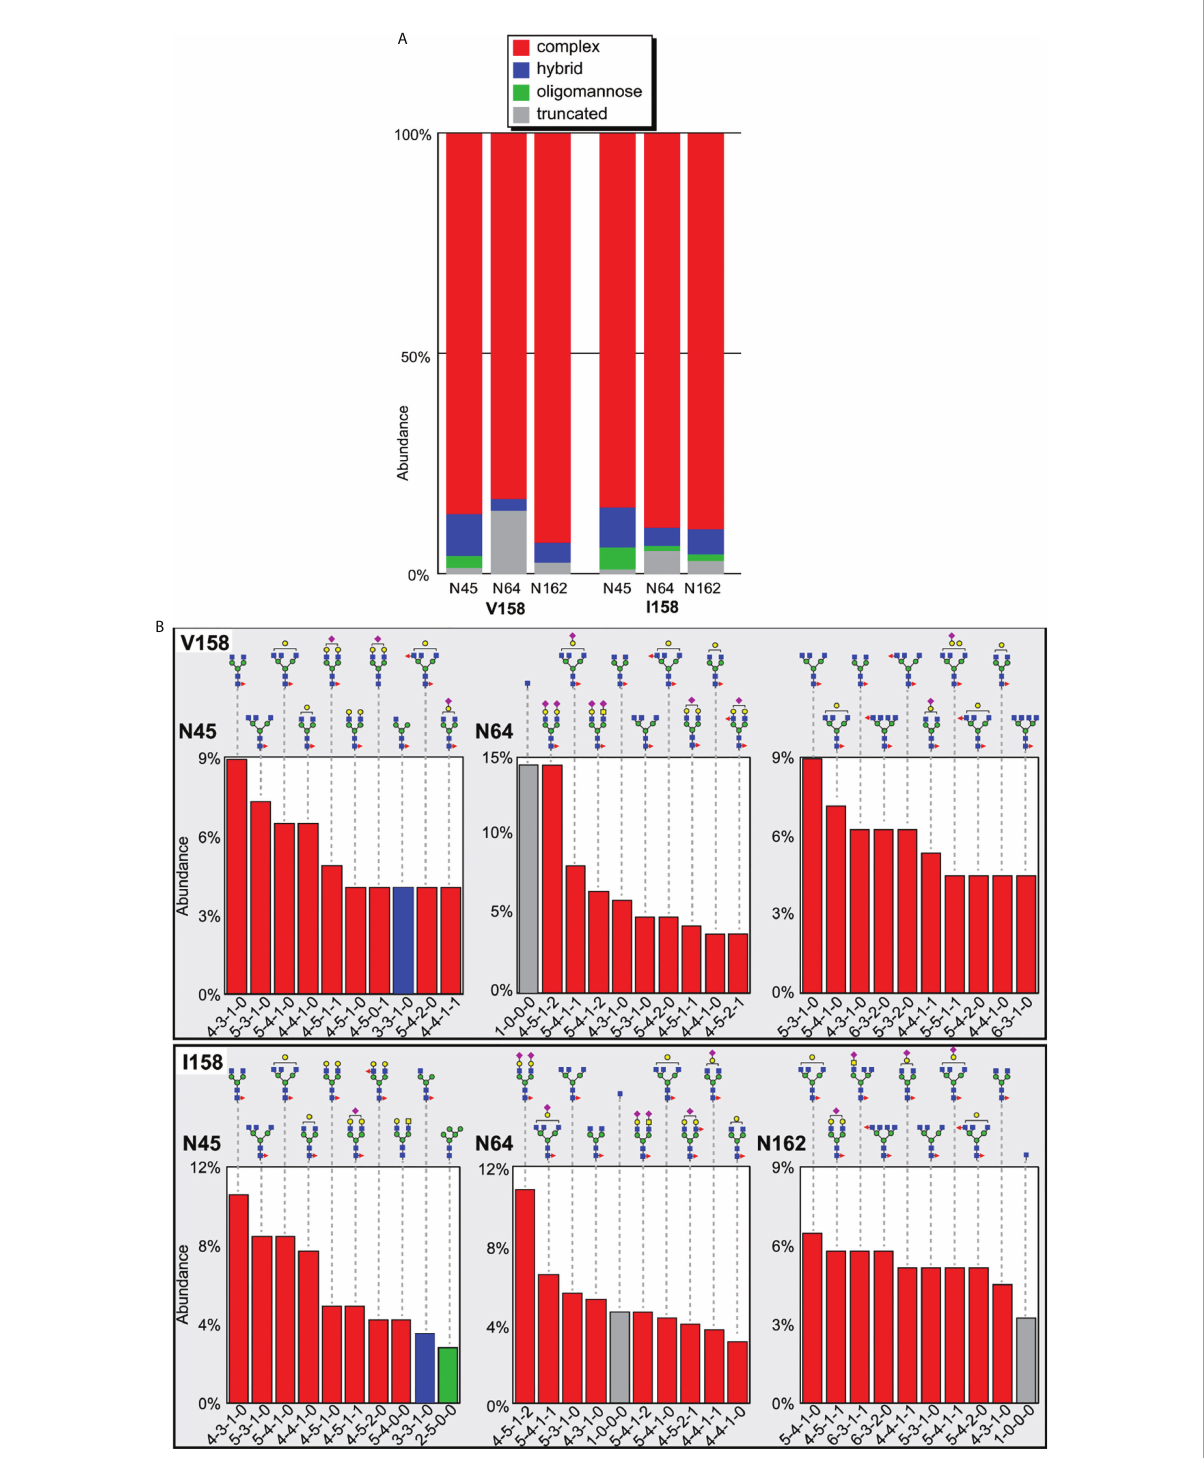
FIGURE 6 Glycan composition of Mm Fc g RIII Val 158 and Ile 158 . (A) Glycoforms identi fi ed at each site. (B) The top ten most abundant N-glycans at each site. Cartoon diagrams represent one possible con fi guration and utilize the SNFG convention for monosaccharides (51); isobaric ions were not distinguished. The composition of each N-glycan is provided below the chart with numbers of N-acetylhexosamine, hexose, deoxyhexose, and N-acetylneuraminic acid residues,